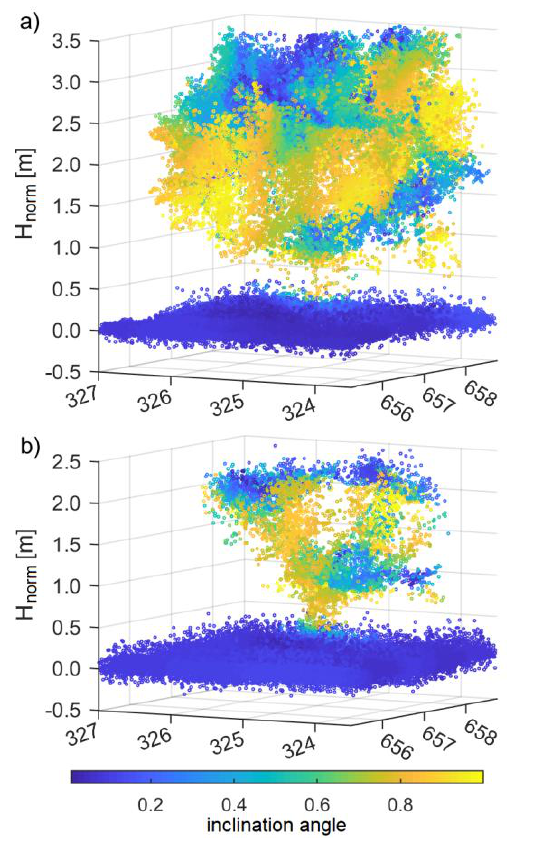
Figure 3. Exemplary point cloud of a tree for the a) leafy and b) leafless season; height coded with value of the inclination angle Height thresholding did not allow to filter out grass